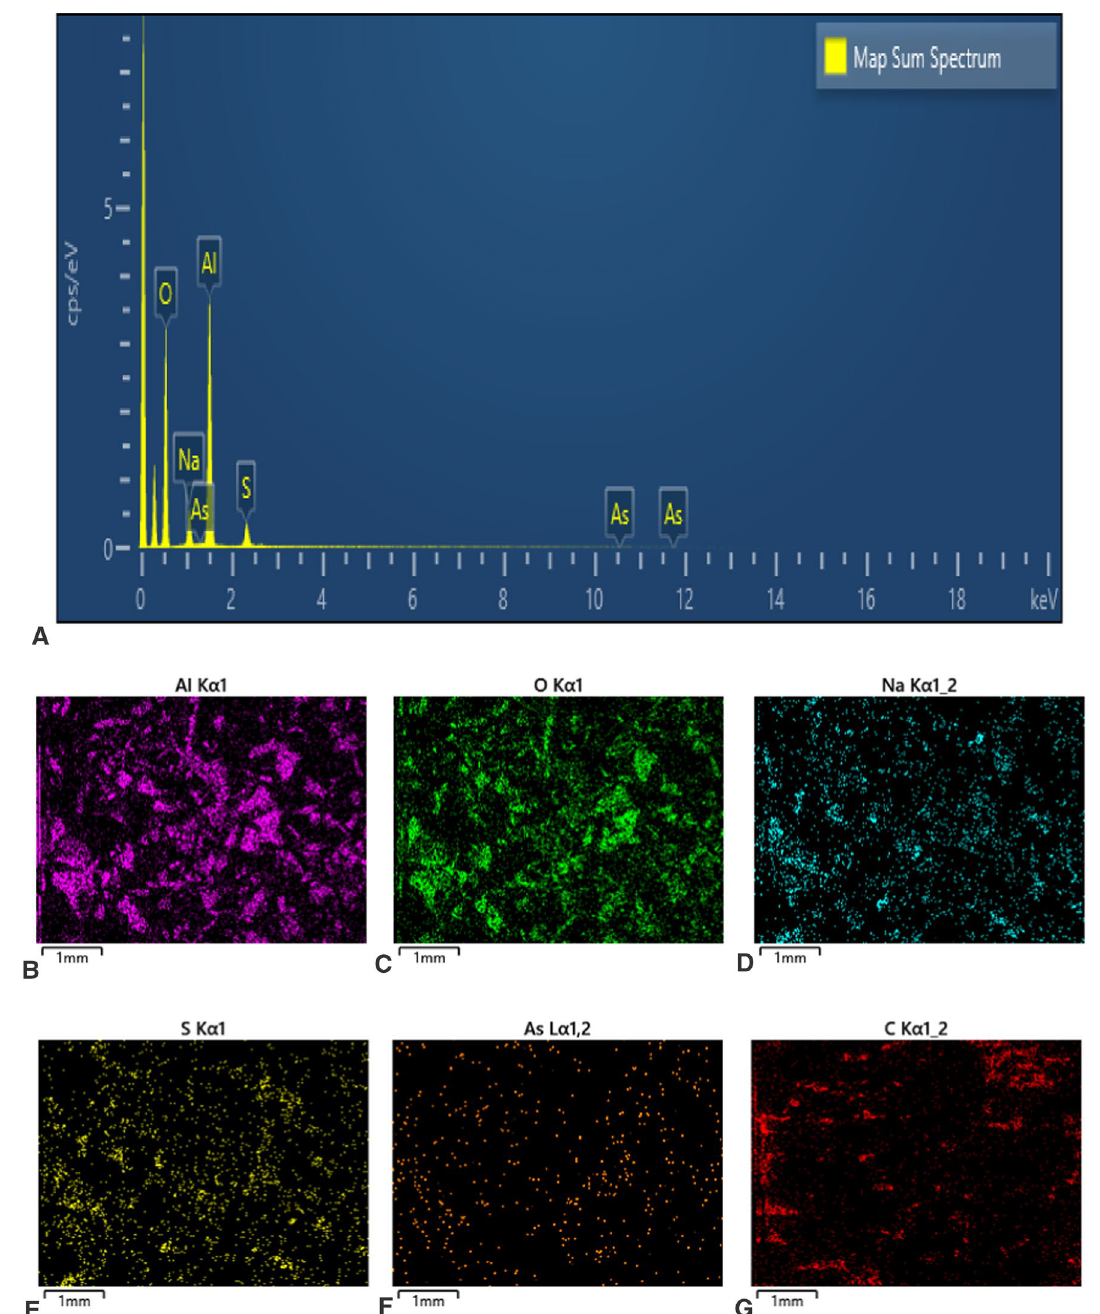
Fig. 10 EDS spectrum of sludge ( a ) and its chemical decomposition b : Al, c: O, d: Na, e: S, f: As,